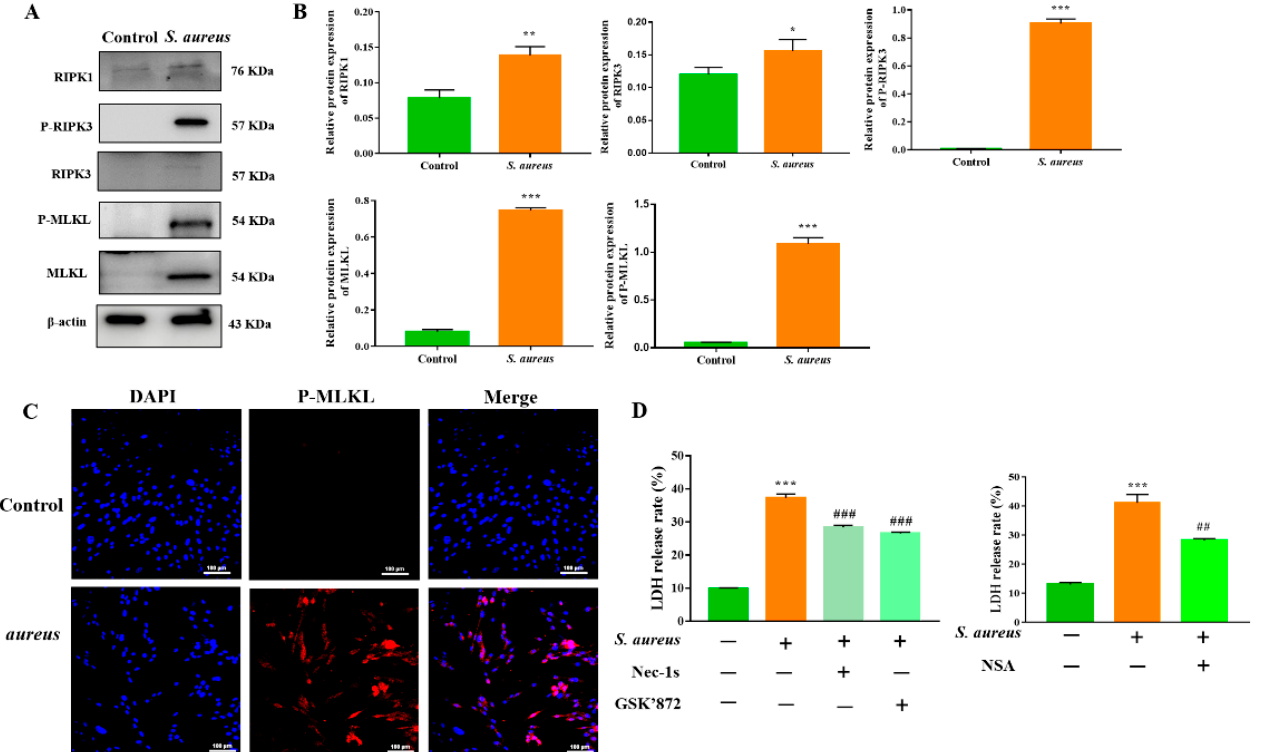
Figure 2. S. aureus induces RIPK1/RIPK3/MLKL-mediated necroptosis in gEECs. ( A ) gEECs were infected with S. aureus (10 MOI) for 4 h; western blot analysis was performed to detect the expression of the necroptosis-associated protein. ( B ) The band intensity was quantified with the ImageJ program and normalized with β -actin. ( C ) IFA analysis of P-MLKL in S. aureus -infected gEECs. ( D ) gEECs were pretreated with the inhibitors of RIPK1, RIPK3, and MLKL (Nec-1s, GSK’872, and NSA) for 2 h, respectively, then infected with 10 MOI S. aureus for 4 h. The cytotoxicity was determined using a CytoTox96 ® non-radioactive cytotoxicity assay kit. * p < 0.05, ** p < 0.01, *** p < 0.001 vs. control group, ## p < 0.01, ### p < 0.001 vs. S. aureus group.